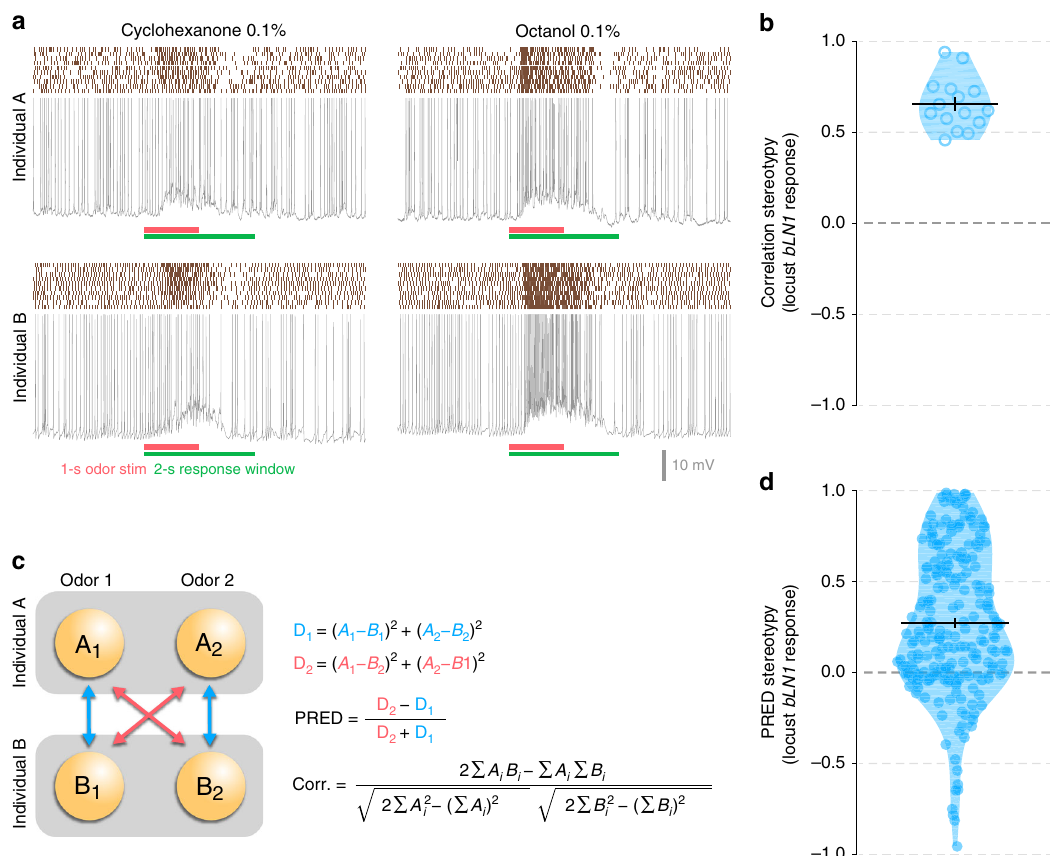
Fig. 1 Stereotypy in locust MBON responses con fi rmed with two metrics. a Raster plots with representative recordings showing responses of the locust bLN1 MBON in two individuals to two odors. Odor was presented for 1 second (red bar) and the spikes in the responses were counted in a 2-s window following odor onset (green bar); scale bar for recordings, 10 mV. In this sample, the responses appear to be stereotypic, with more spikes for octanol 0.1% and fewer spikes for cyclohexanone 0.1 % in both the individuals. b Violin plot showing the value of correlation stereotypy in bLN1 responses in the locust dataset. Each point represents the Pearson ’ s correlation coef fi cient, calculated using the 6-length vector (responses to 6 odors) for a pair of individuals ( n = 15 pairs of individuals). c Schematic description of the PRED metric for stereotypy and comparison with the correlation metric. d PRED stereotypy in bLN1 responses in the locust dataset used in ( b ). Note the bias towards positive values. Each point represents the pairwise PRED stereotypy value, calculated for a pair of odor responses in a pair of individuals, giving a total of 225 values (15 pairs of odors × 15 pairs of individuals). In b , d black horizontal line represents the mean. Error bars represent